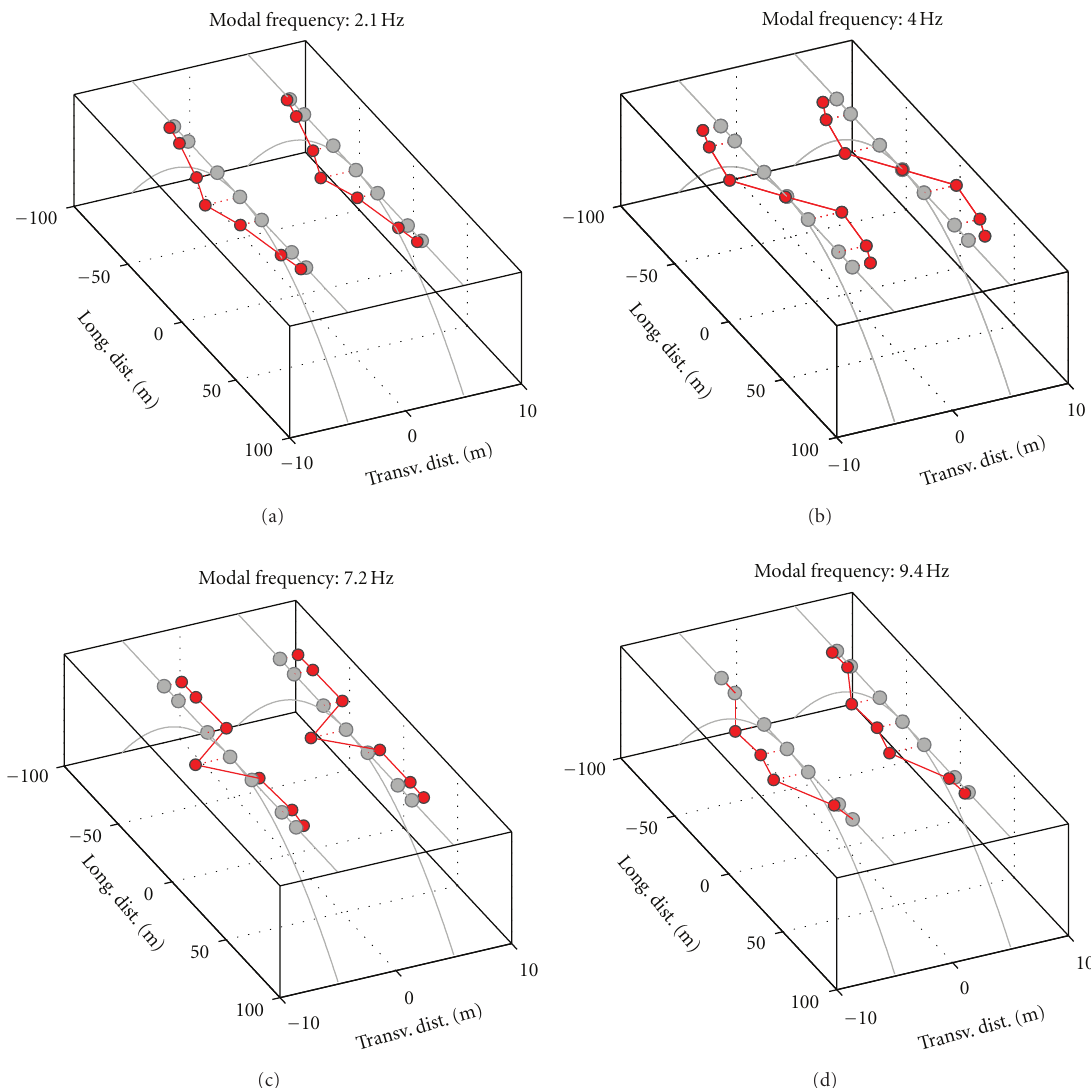
Figure 8: Modal shapes (transversal component) illustrating the motion of the entire deck in the transversal direction. Note that the relative amplitude of displacement in the transverse direction is